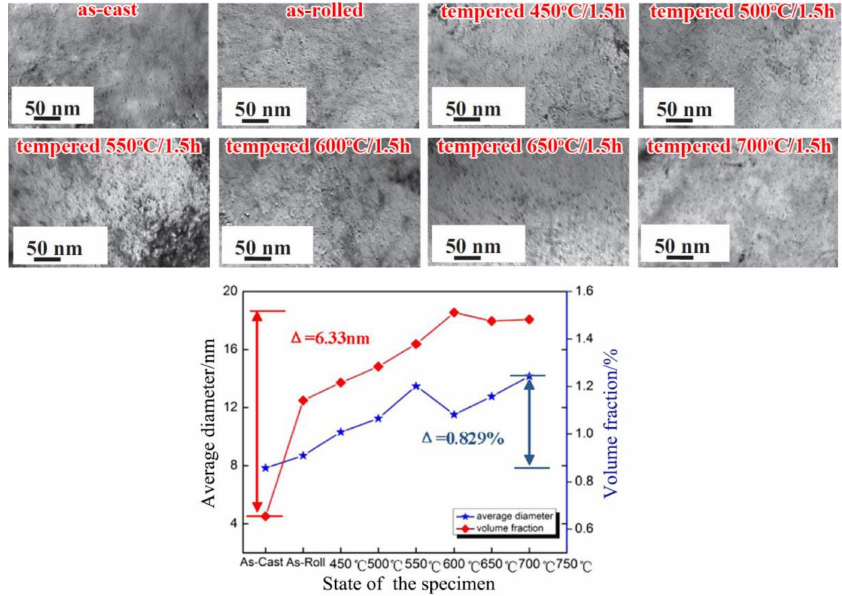
Figure 10. Bright field image (TEM) of the Ni-Cr-Mo-V-Nb-Ti ship steel in different states and average diameter and volume fraction of the nano-particles in different states